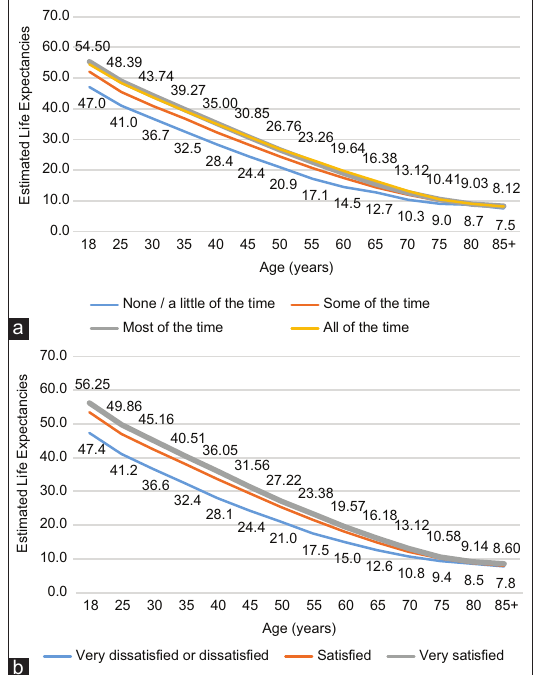
Figure 1: (a, b). Age-specific life expectancies by levels of happiness and life satisfaction, United States,